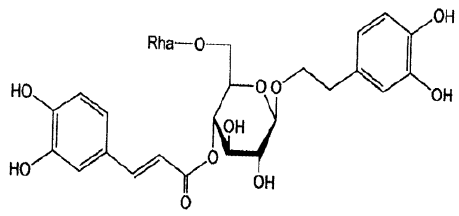
Figure 2. Chemical structure of forsythiaside.